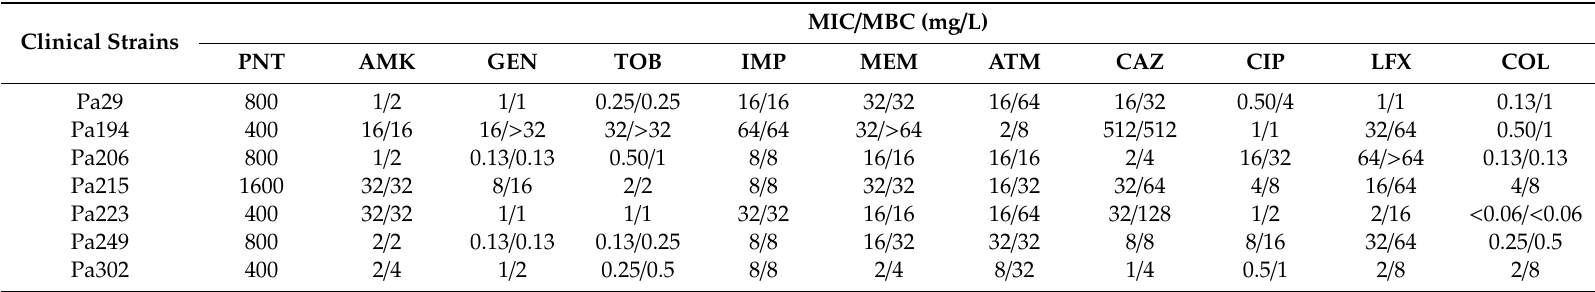
Table 1. MIC / MBC of the di ff erent antimicrobials for the seven MDR Pseudomonas aeruginosa clinical strains.